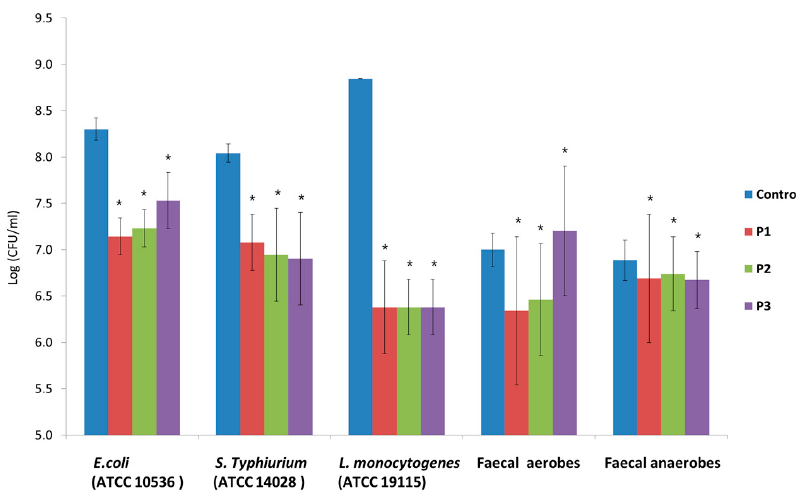
12 of 22 Figure 7. Microphotographs (magnification × 1000) showing adhesion of Lactobacillus sp. to Caco-2 cells in the presence of and without apple pomace hydrolysates: ( a ) Lb. plantarum 0991, ( b ) Lb. plantarum 0991 + preparation P1, ( c ) Lb. plantarum 0989, ( d ) Lb. plantarum 0989 + preparation P3. 3.6. Adhesion of Pathogens and Fecal Bacteria in the Presence of Apple Pomace Hydrolysates The applied pathogen strains adhered in large amounts to the Caco-2 cells. The most adhesive was L. monocytogenes (ATCC 19115), with 7.0 × 10 8 CFU/mL of adhered bacteria, and the least adhesive was S. Typhimurium (ATCC 14028), with 1.1 × 10 8 CFU/mL of adhered bacteria. The tested fecal aerobes and anaerobes adhered to the Caco-2 cells at similar levels (approx. 1.0 × 107 CFU/mL of adhered bacteria). In the presence of the applied AP hydrolysates, a reduction was observed in the number of adhered bacteria in the cases of all the tested pathogens (Figure 8). These changes were at a similar level in the presence of all three preparations. The largest reduction in the number of